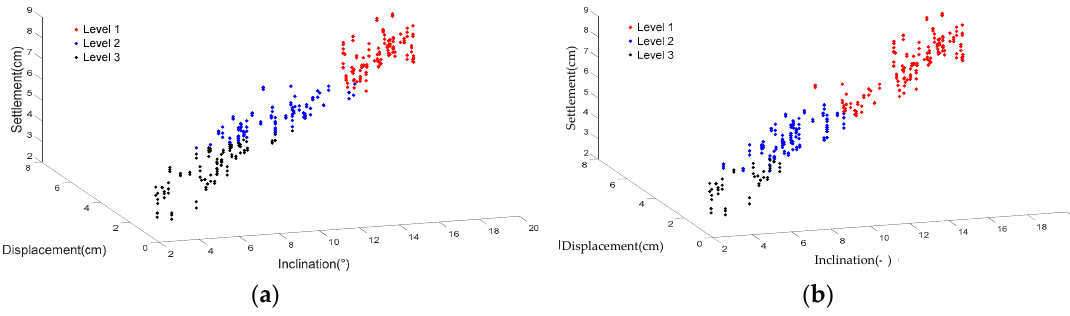
Figure 14. Two different predicted results of the damage level classification pattern ( Ι ): ( a ) and ( b ) were two different predicted results in different simulation processes.